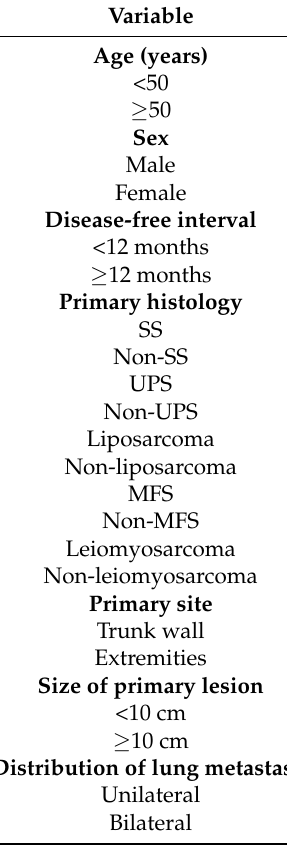
Figure 1. Kaplan–Meier disease-specific survival curve after pulmonary metastasectomy. Table 2. Univariate Analyses of the Factors Associated with Disease-specific Survival after Pulmonary Metastasectomy.